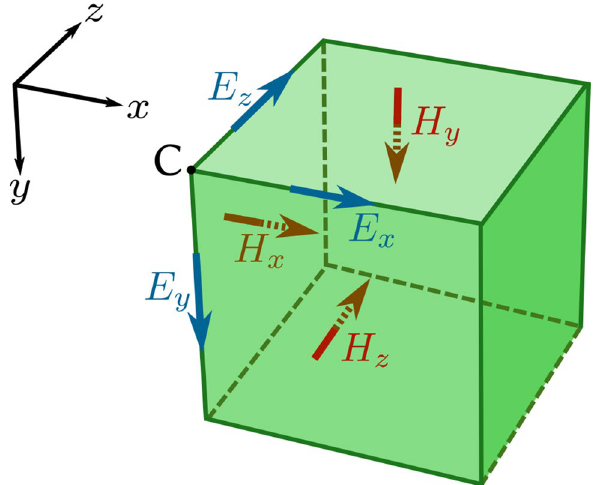
Figure 5. The Yee cell is the grid unit for FDTD simulations. The electromagnetic fields are staggered with half- integer offsets from the corner of the grid cell (marked as C ). The E -fields are on the edges of the unit cell, the H -fields are on the faces of the unit cell. This figure was created with